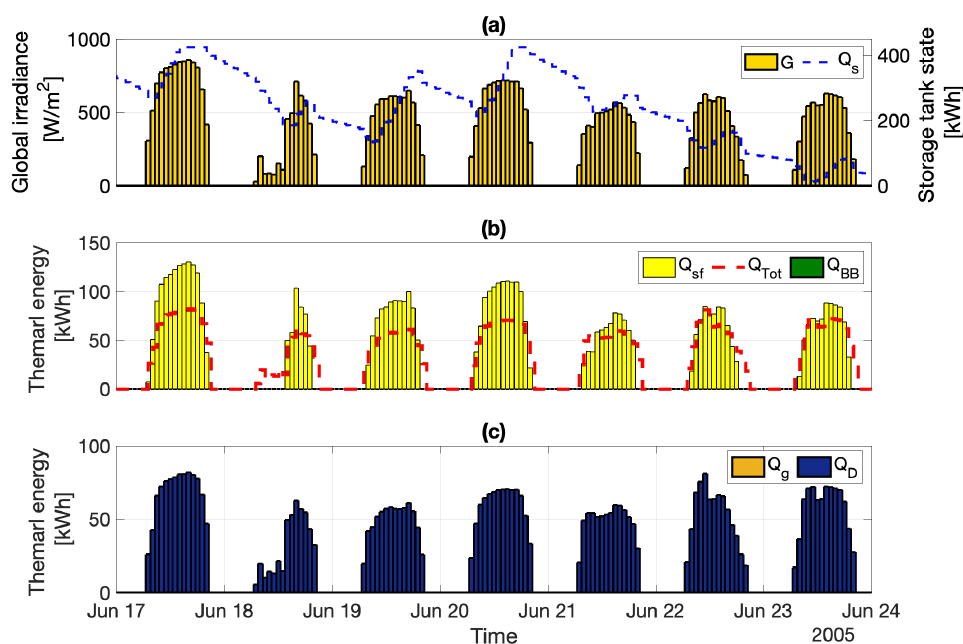
Figure 8. Simulation results during the week of 17 to 24 June. ( a ) Global irradiance ( G ) and storage tank state ( Q s ), ( b ) the total thermal energy demand of the system ( Q Tot ), contribution of the biomass boiler ( Q BB ) and contribution of the solar field ( Q sf ), and ( c ) the greenhouse thermal energy demand ( Q g ) and thermal desalination facility demand ( Q D